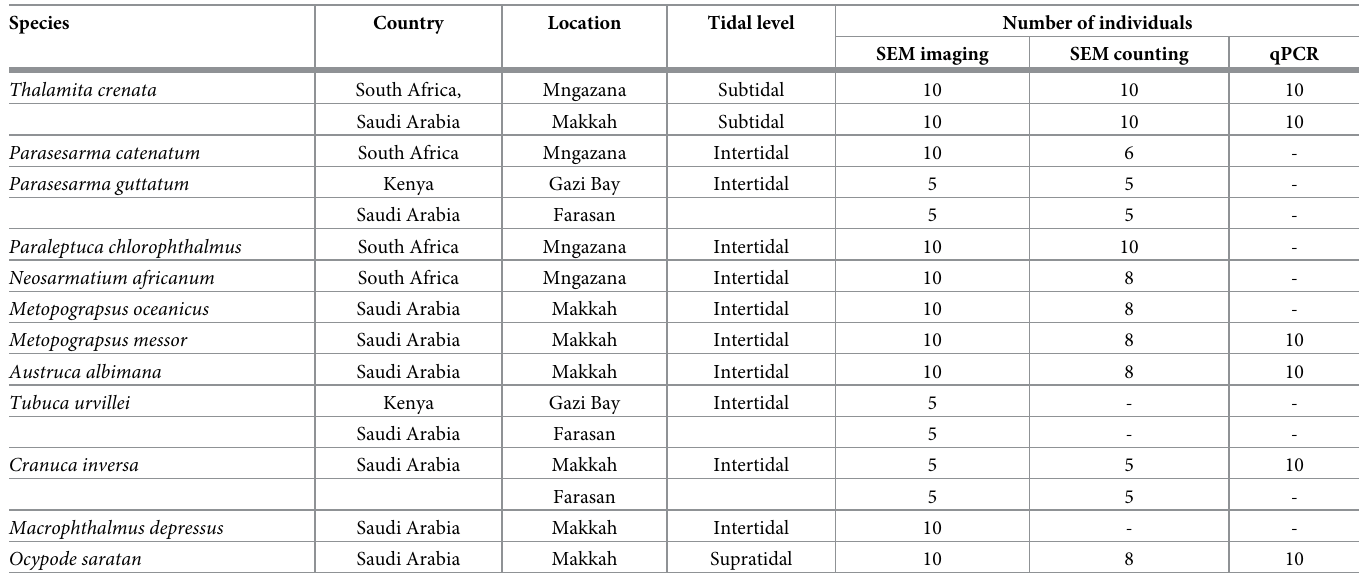
Table 1. Sampling details: Location, tidal level occupied and the number of specimens collected for each analysis are shown for each species.